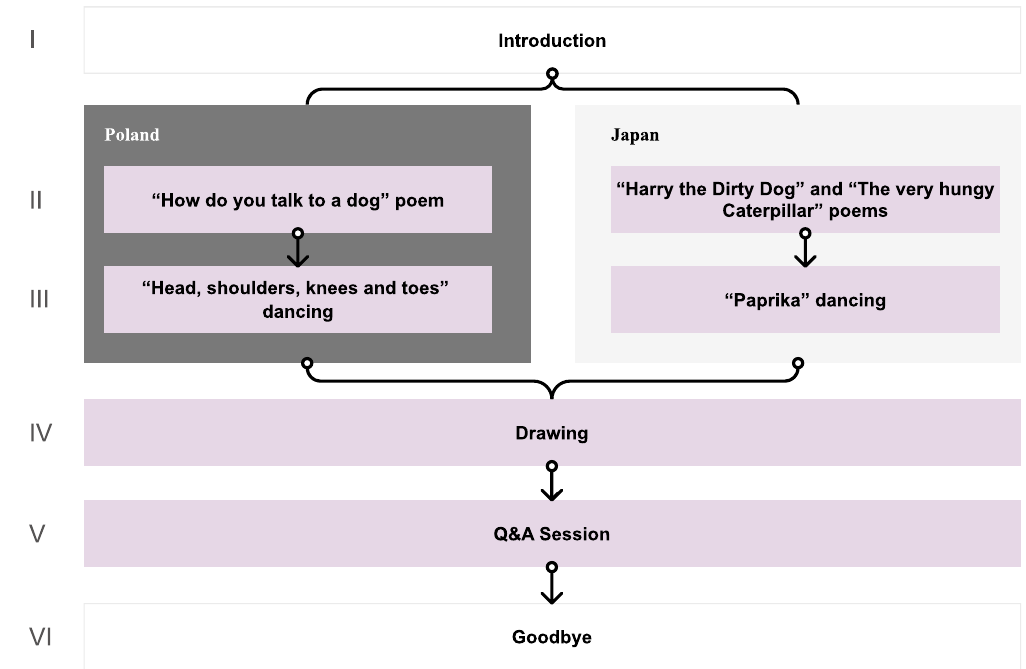
Figure 1. The experimental